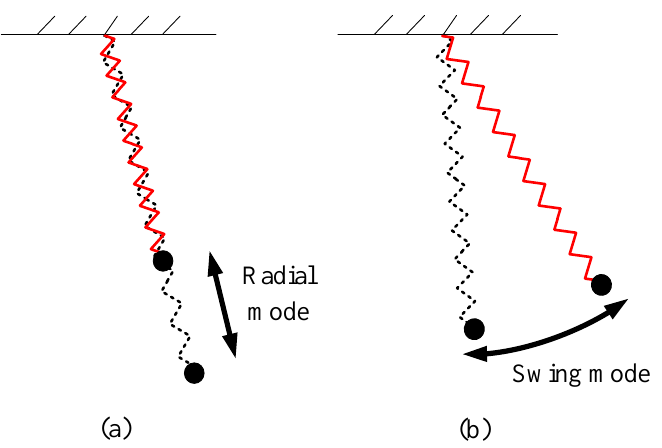
Figure 3. Vibration modes of the SP. ( a ) Radial mode; ( b ) Swing mode.